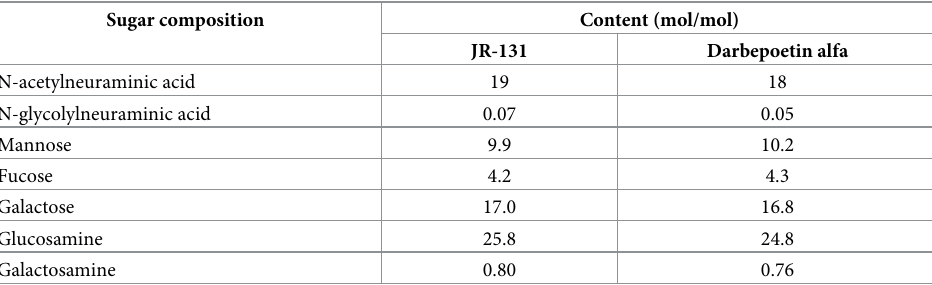
Table 2. Sugar composition of JR-131 and darbepoetin alfa.